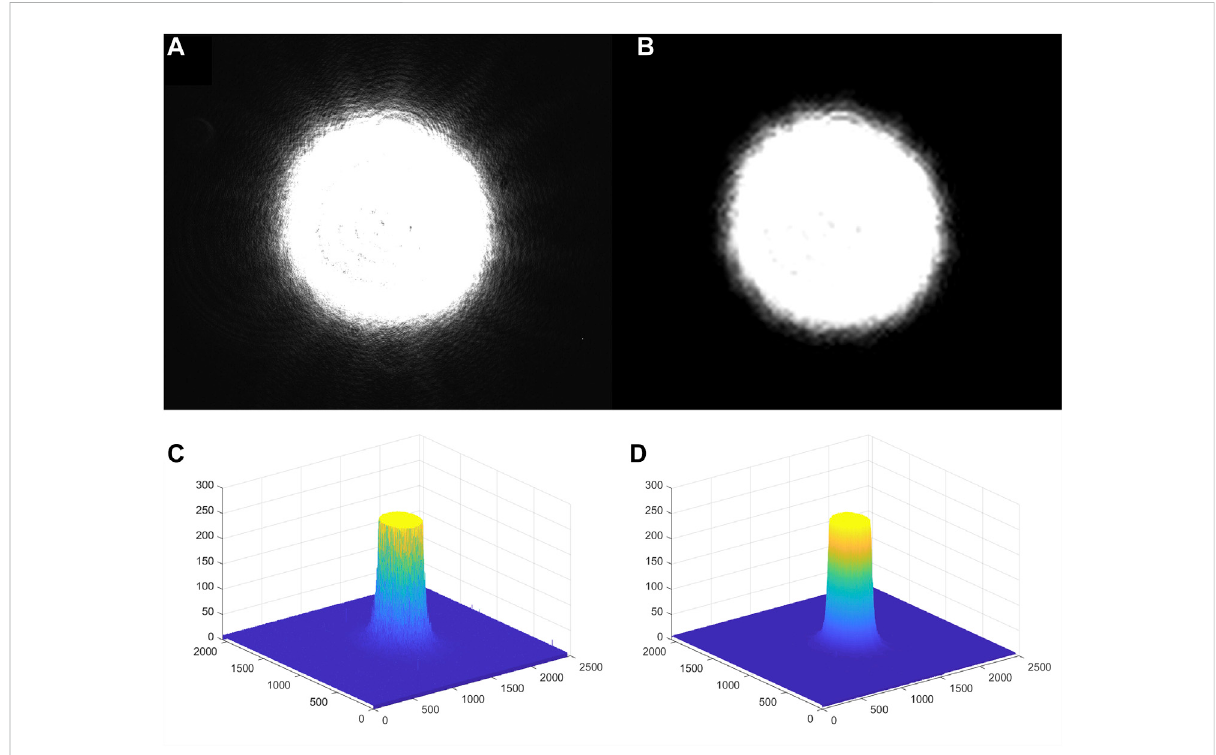
FIGURE 3 Comparison of before and after laser spot image denoising. (A) : Image before denoising; (B) : Image after denoising; (C) : Grayscale Value distribution before denoising; (D) : Grayscale Value distribution after denoising.